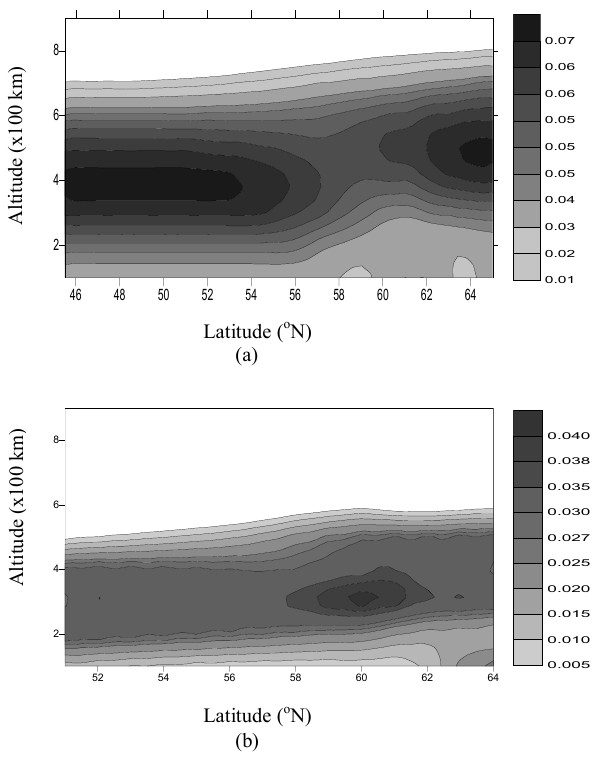
Fig.3. Relative slant TEC versus arrival angle of signal at the three receivers located in Alaska USA for 26 February 2003 (left panels) and 14 July 2003 (right panels). Negative values of arrival angles are for satellites to the north of the receivers.